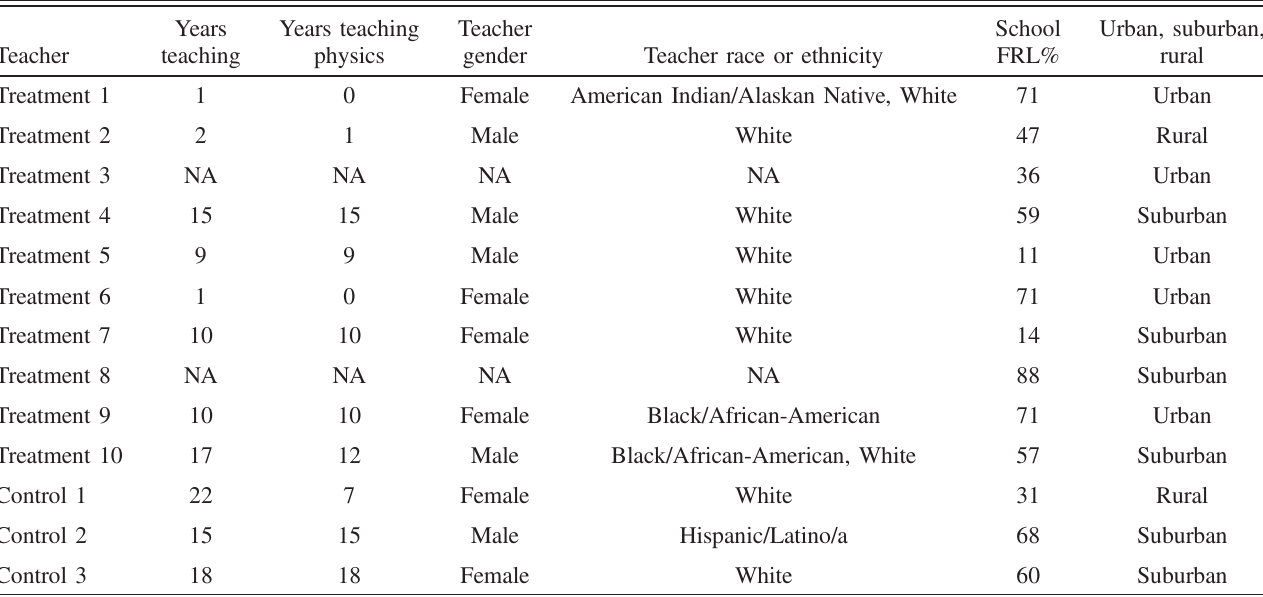
TABLE IX. Summary of teacher or school characteristics, Study 2. NA represents a response not self-reported by the teacher.